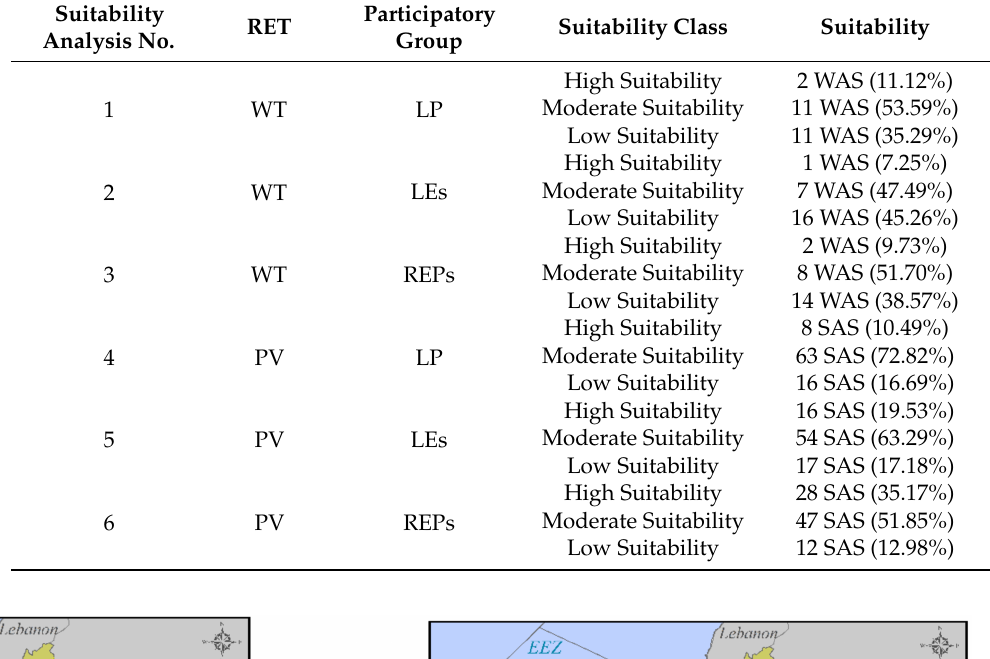
Table 6. Suitability analyses results using Geographic Information Systems (GIS) (final results of the Planning module).